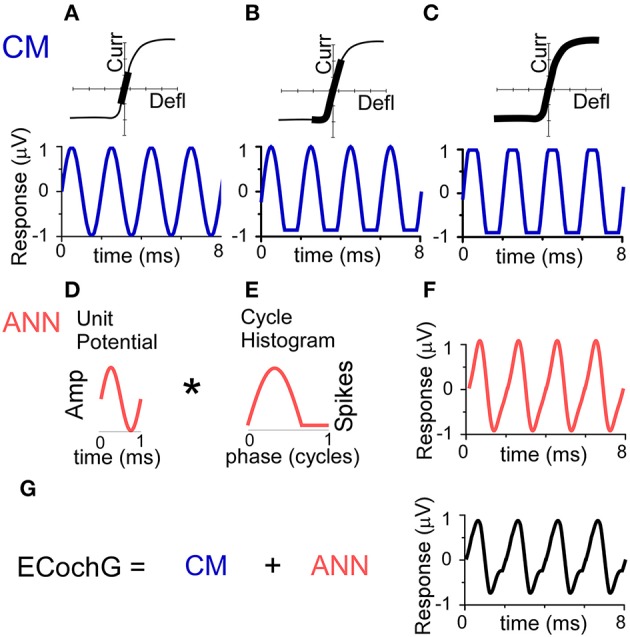
Conceptual basis of the model for the ongoing part of the ECochG response to low frequency tones. (A–C) The CM. To a low stimulus intensity (A), the hair cell stereociliary motion and channel openings operate symmetrically within the input-output function (top, black bar), producing a sinusoidal CM response (bottom). (B) With increasing stimulus intensity, asymmetric saturation can occur if the operating point (average state of the channels at rest) is displaced from the center of the function (top), producing a CM saturated only to one side of motion, in this case the trough of the CM (bottom). (C) With a high stimulus intensity, symmetric saturation occurs with maximal deflection at both ends of the oscillation (top), creating a CM with saturation to both the peak and trough. (D–F) The ANN is created by the convolution (*) of the unit potential (D) and the population cycle histogram (E). The unit potential is the shape of a single action potential at the round window, and the cycle histogram is the sum of action potential firing in the population of the across all responding nerve fibers. Because the cycle histogram is derived by folding the periods in the post-stimulus time histogram, this process is identical to that previously modeled to produce the CAP (see text for references). The non-linearities inherent in this process will always create a distorted version of the cyclic response (F). (G) The ongoing ECochG represents the sum of the CM and ANN.